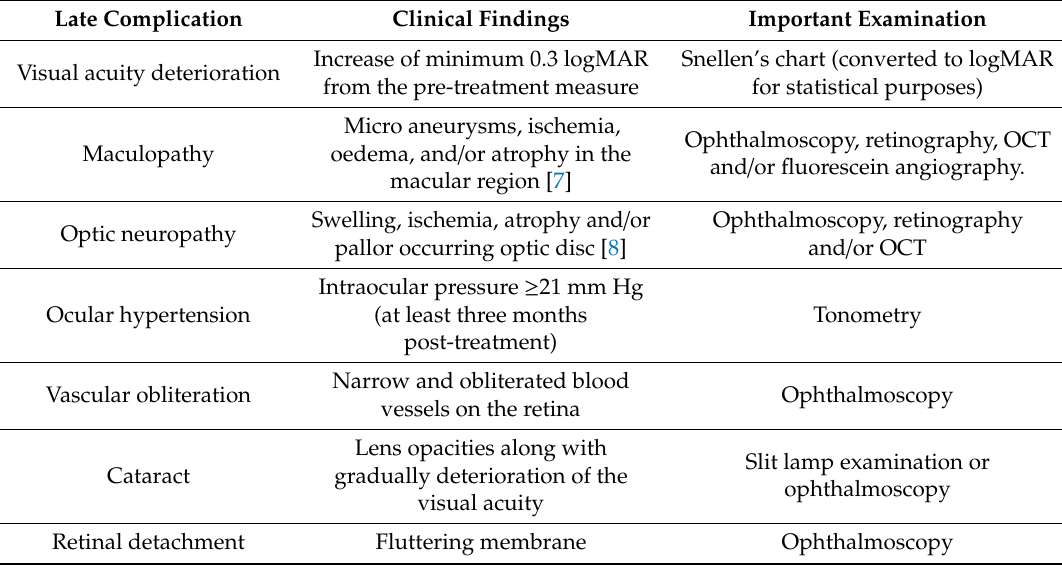
Table 1. List of the considered late complications, the clinical findings for each, and the equipment used in the examination. OCT: optical coherence tomography, logMAR: the logarithm of minimum angle of